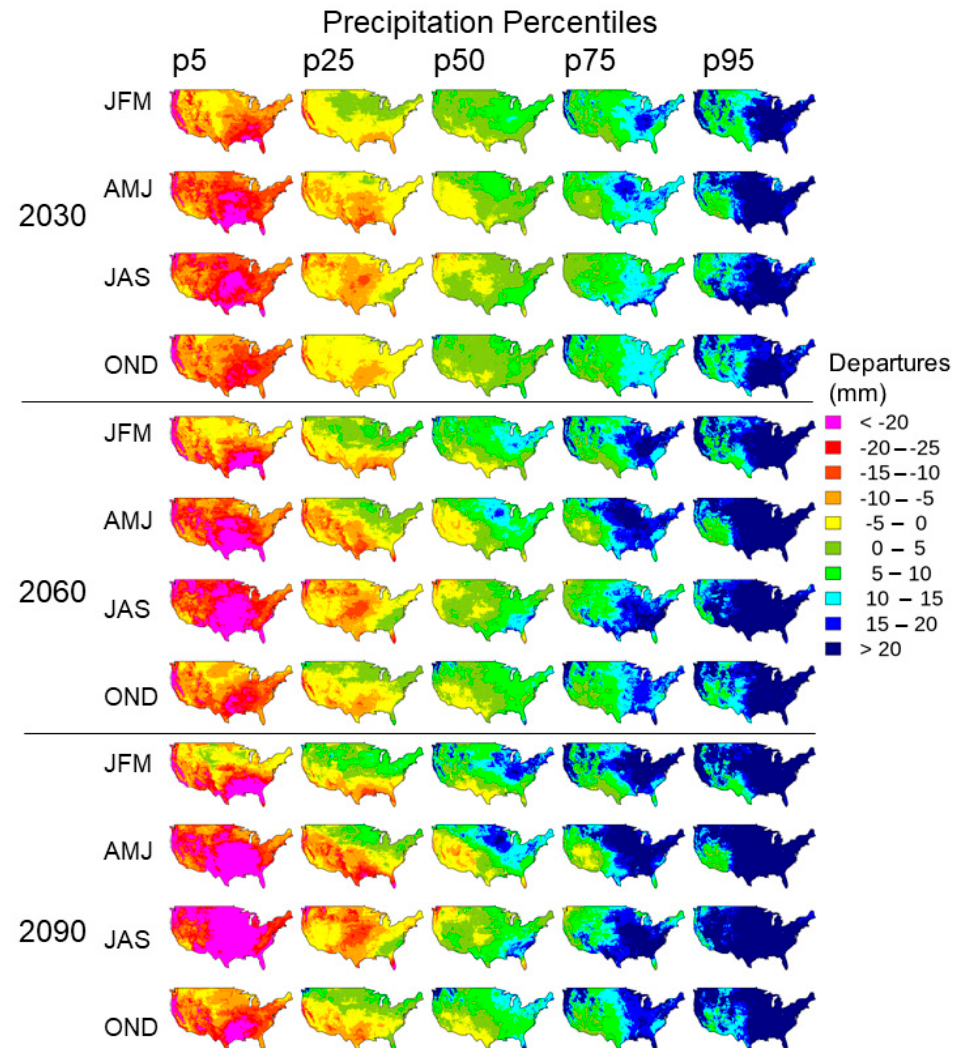
Figure 4. Departures in seasonal average monthly precipitation in millimeters (mm) by